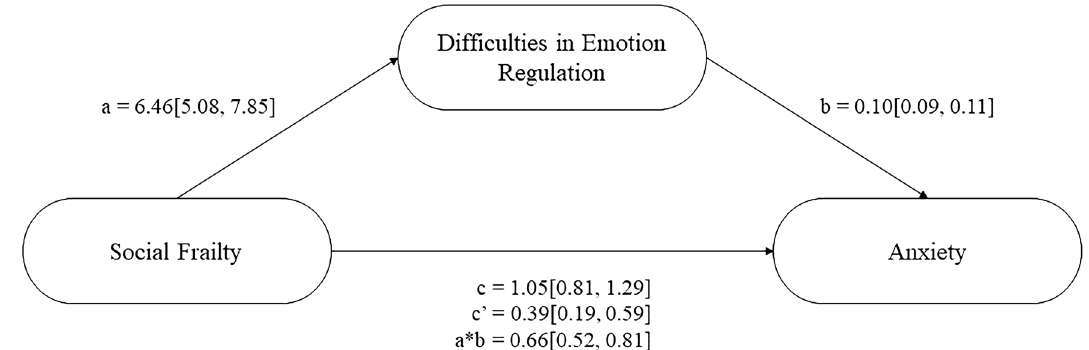
Figure 2. Difficulties in emotion regulation as a partial mediator between social frailty and